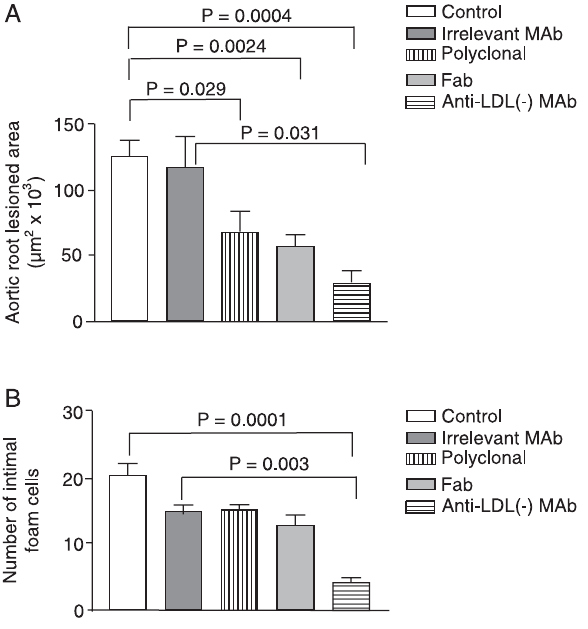
Figure 1. Atherosclerotic lesions of low-density lipoprotein re- ceptor-deficient (LDLr-/-) mice treated with antibodies against LDL(-). A, Cross-sectional area of atherosclerotic lesions at the aortic root of LDLr-/- mice; B, number of foam cells in the subin- timal layer of atherosclerotic lesions of LDLr-/- mice treated or not with anti-LDL(-) monoclonal antibody (MAb, 100 µg), irrel- evant Mab (100 µg), rabbit polyclonal anti-LDL(-) antibody (100 µg) and Fab fragments from rabbit anti-LDL(-) polyclonal anti- body (100 µg). P < 0.05, ANOVA followed by the Tukey-Kramer